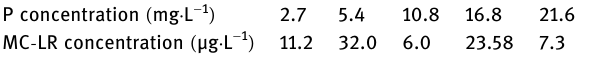
Table 3: The variation of MC - LR concentration of M. aeruginosa cultured under varying P without N ( N - starved conditions